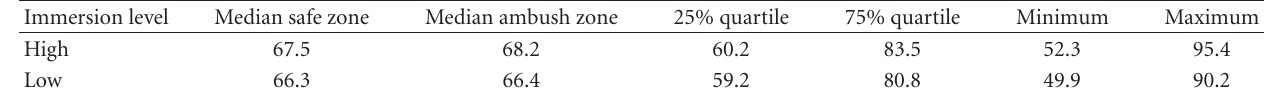
Table 2: Distribution statistics for heart rate results.